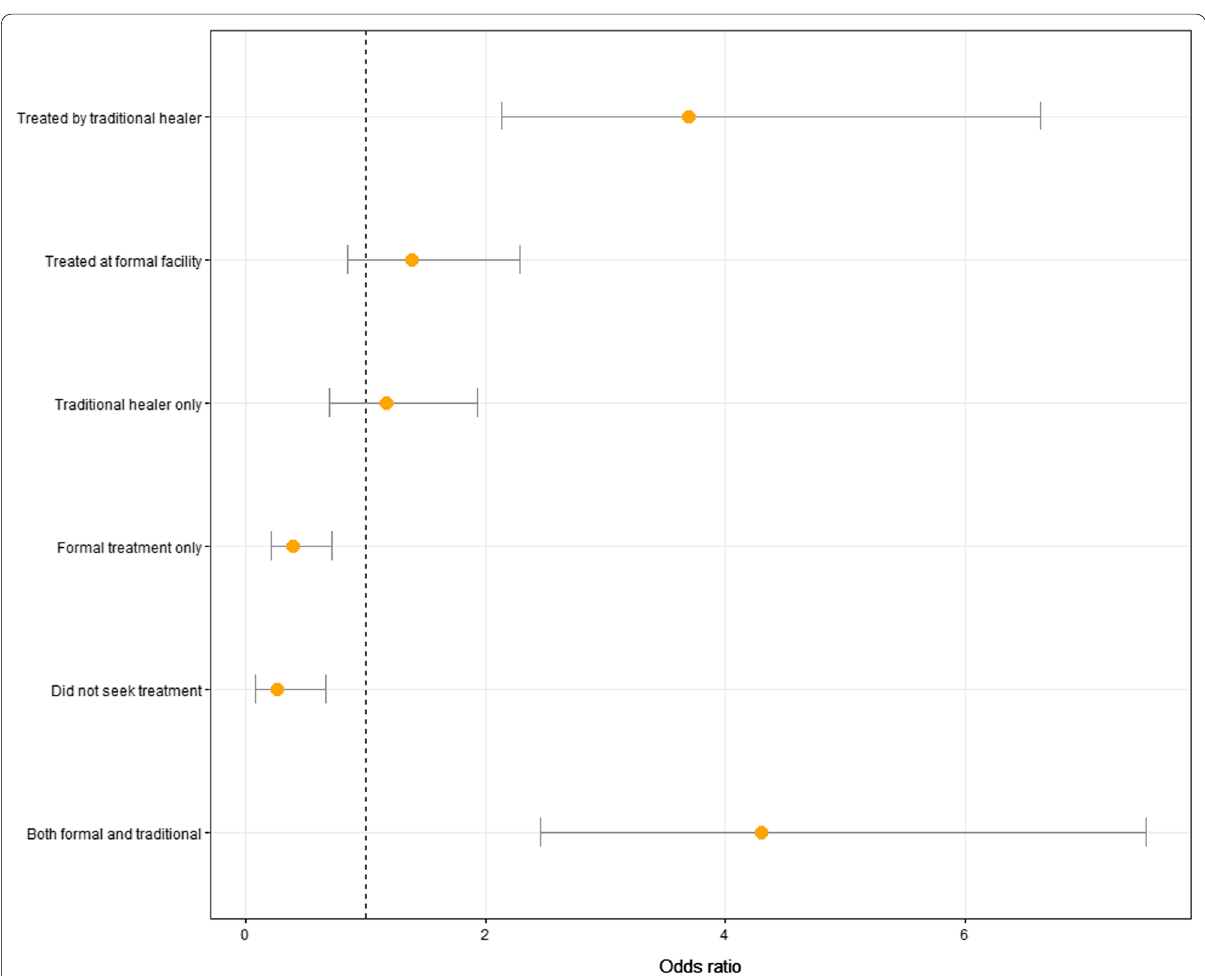
Fig. 3 Odds ratios and confidence intervals from bivariate logistic regression models of severe outcomes (defined as death, paralysis, permanent disability or loss of consciousness) and various treatment